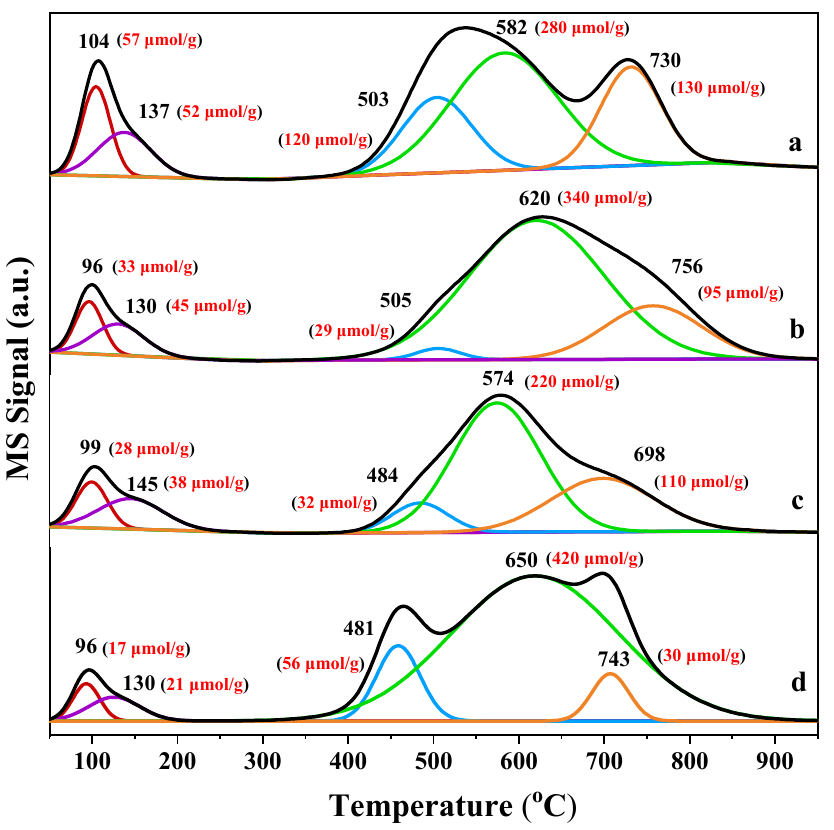
Figure 6. CO 2 − TPD of supported gold catalysts: ( a ) Au 25 /Zn 3 Al-400; ( b ) Au 25 /Zn 2 Al-400; ( c ) Au 25 /Zn 1 Al-400; ( d ) Au/Zn 2 Al-400.